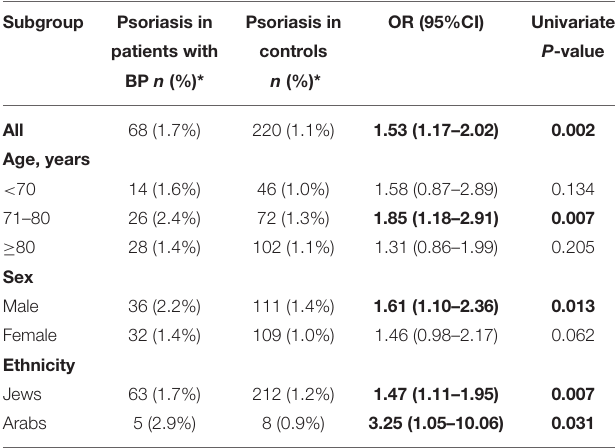
TABLE 3 | The risk of bullous pemphigoid in patients with a preceding diagnosis of psoriasis stratified by age, sex, and ethnicity (case-control study design).